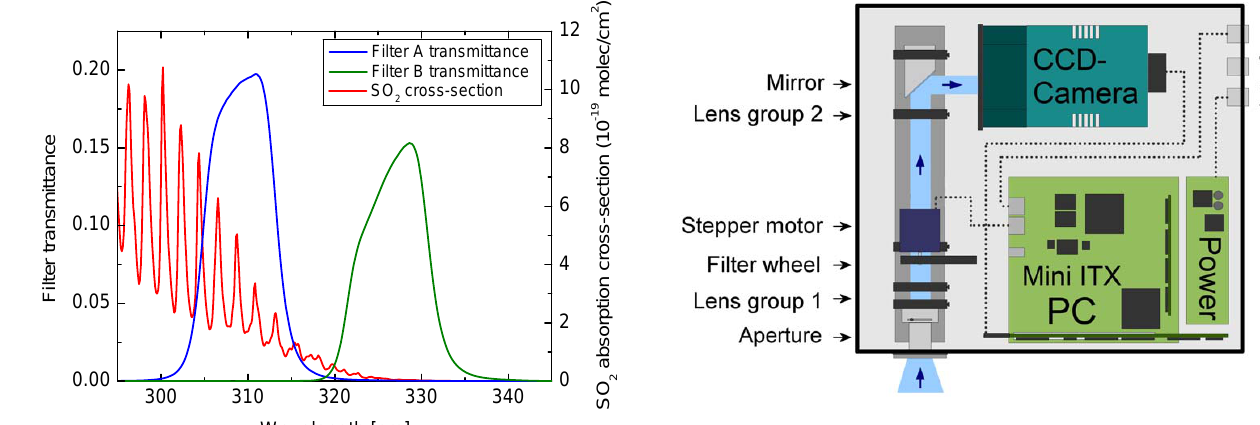
Figure 10. Schematic setup of the SO 2 camera prototype. Light enters the instrument through an aperture, passes through the band-pass filter and is focused on the CCD detector. The measurement is controlled by an internal ITX PC, and data is saved on an internal hard drive. The interface connectors are used to configure the measurement and collect data, as well as for supply of 12V DC power.